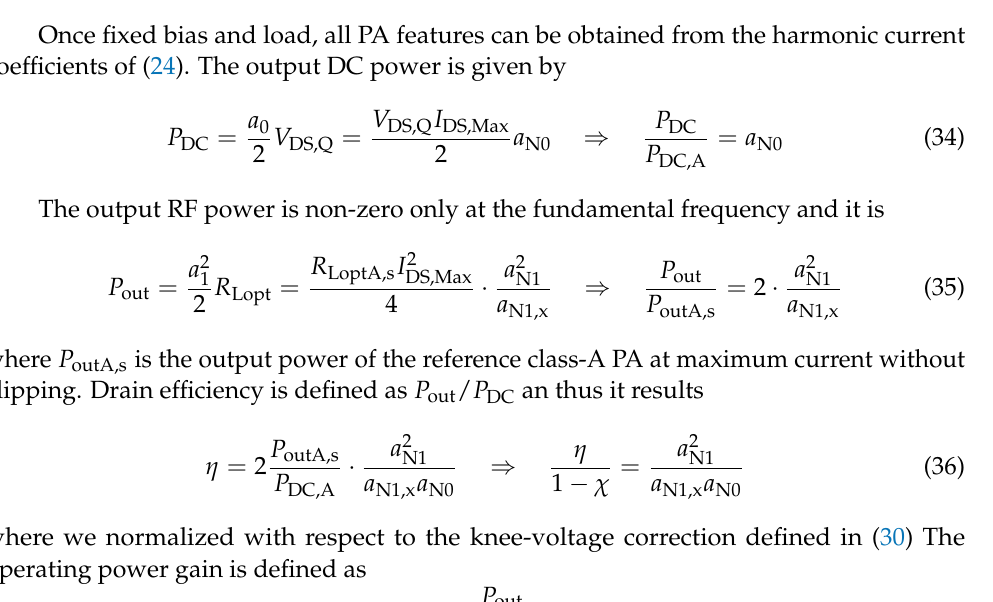
Figure 10. Normalized optimum load resistance as a function of the biasing class for different β x